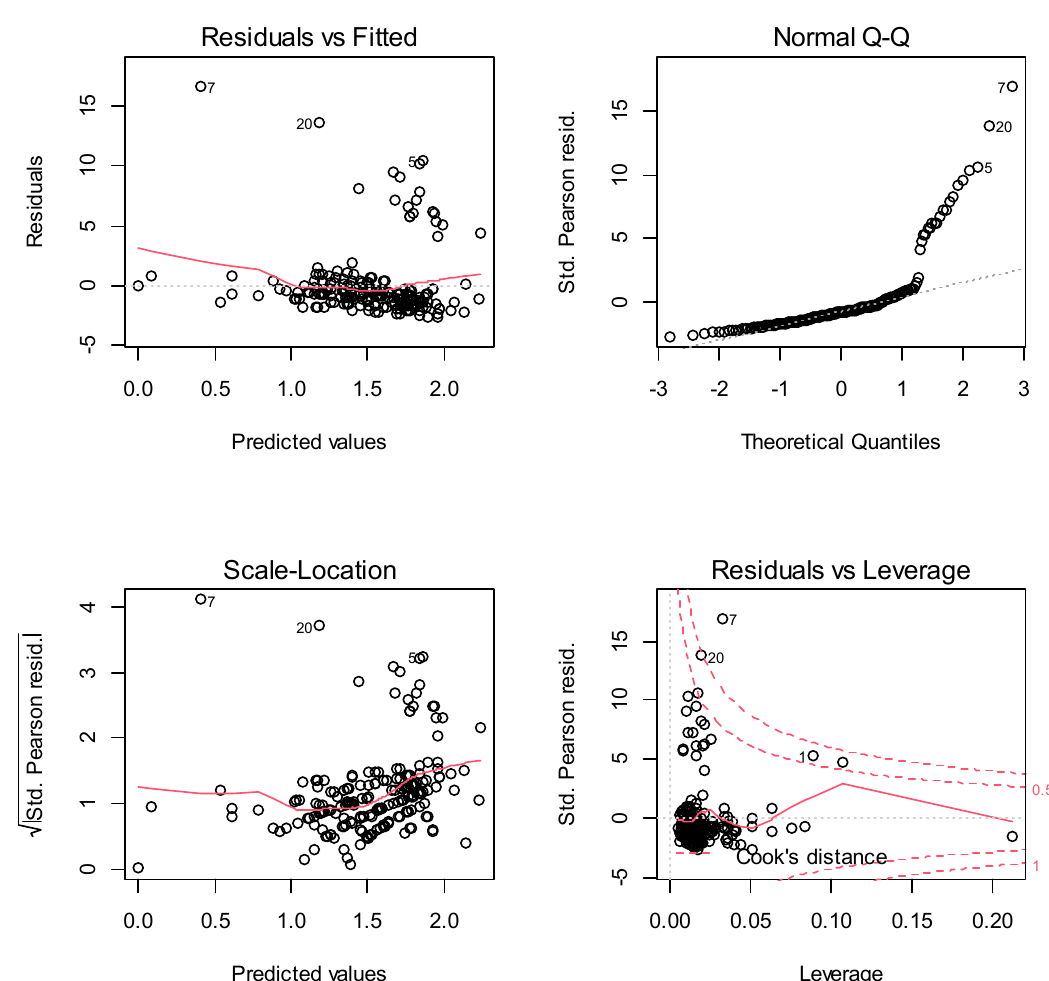
Figure 4. Residuals analysis of the Somerville Lake data. Table 2. Estimated coefficients and MSEs of the Somerville Lake